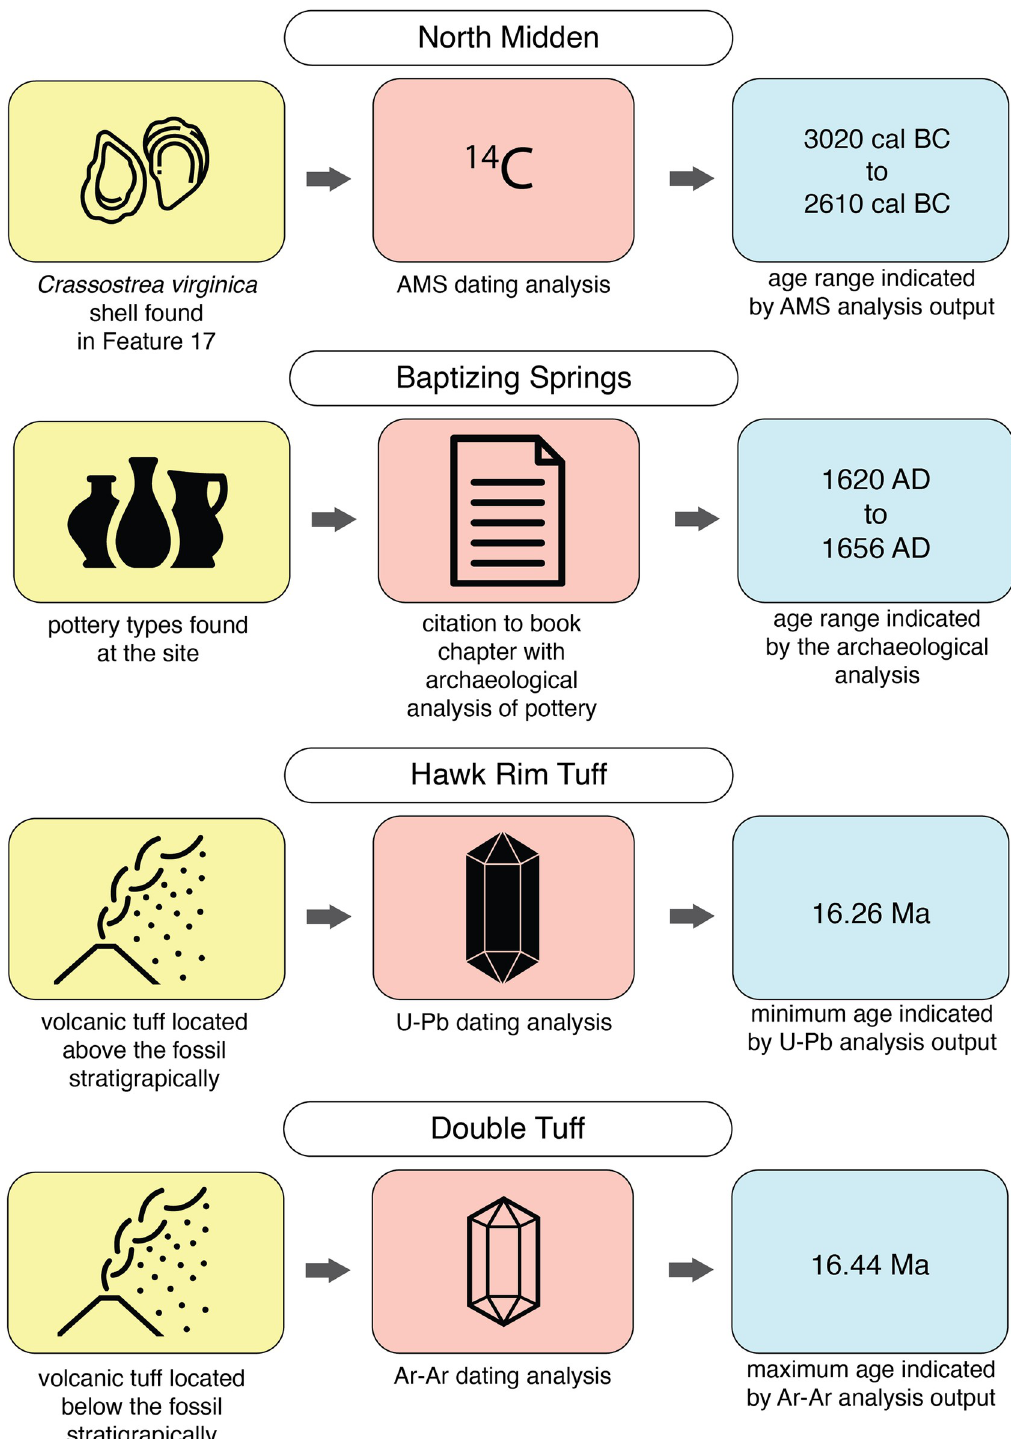
Fig 2. Exemplar material samples, data assays and outcomes of the three example datasets, with color coding to indicate how the different parts of the dating process correspond with the CAE terms in Table 3 and conceptual elements in Fig 1. “Oyster” icon by Eucalyp, “Ceramics” icon by Adrien Coquet, “Article” icon created by IconMark, “Volcanic Ash” icon created by Hayashi Fumihiro, “Crystal” icons created by MarkieAnn Packer all from http://www.thenounproject.com.